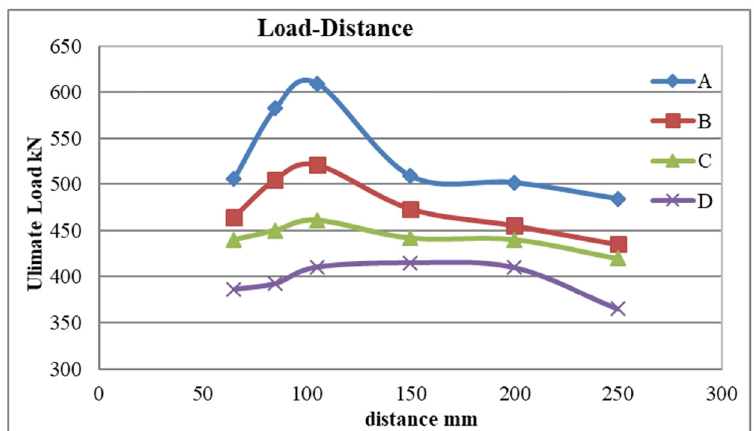
Figure 17: The curve of ultimate load – de fl ection for all